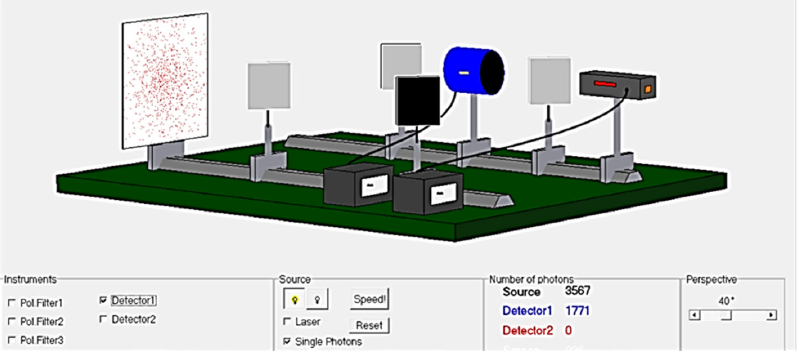
FIG. 7. Screen shot of the computer simulation in which an additional detector (blue device) is placed in one of the paths of the MZI. Simulation developed by Albert